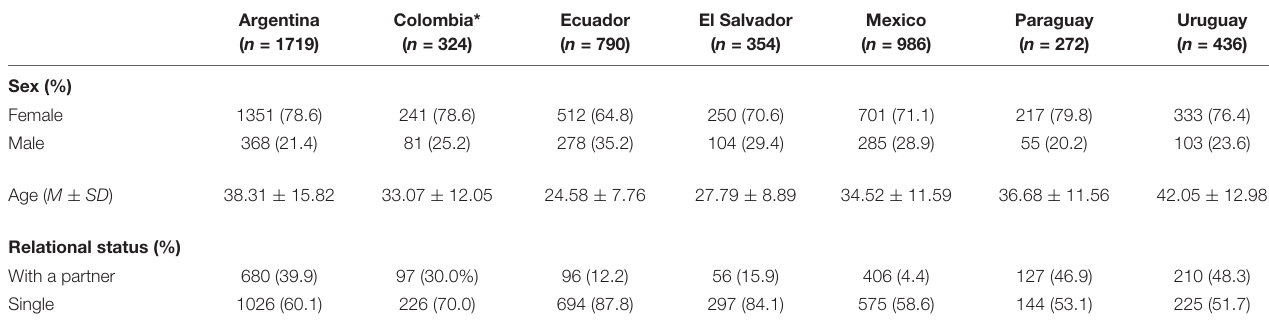
TABLE 1 | Sample demographic characteristics by